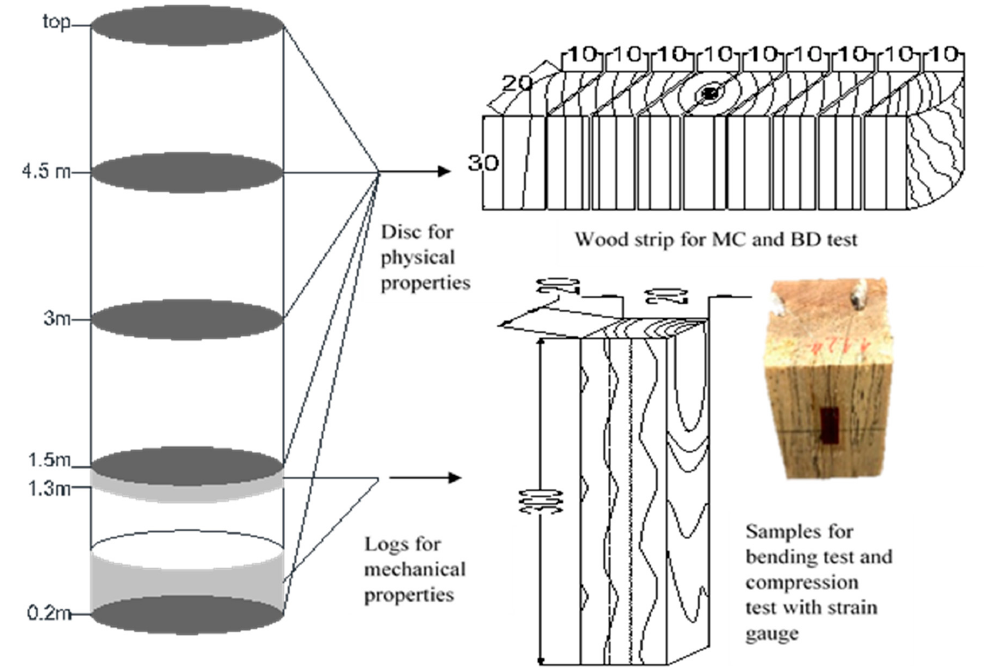
Figure 1. Sampling methods for discs and logs and test samples for physical and mechanical properties. (MC, moisture content; BD, basic density)